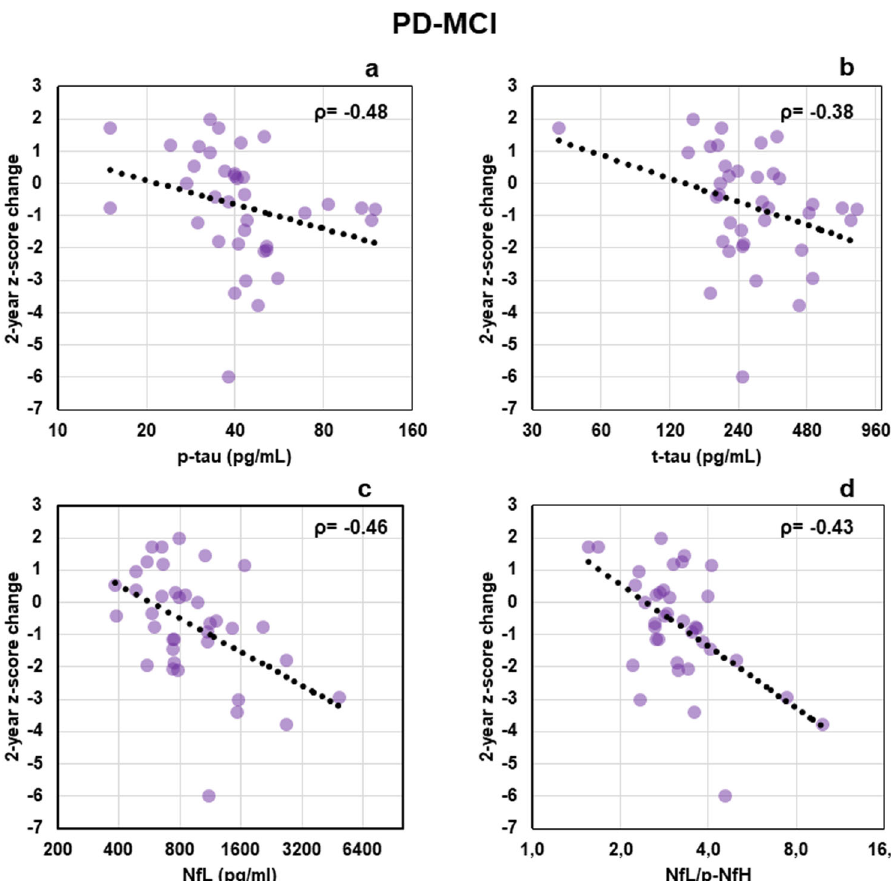
Fig. 2 Scatter plots of correlations between biomarkers and Z -score change of cognitive tests. a p-tau, b t-tau, c NfL, d NfL/p-NfH. The reported correlations produced, in the different groups, Spearman correlation coef fi cients signi fi cantly different from 0 after FDR correction and p -values < 0.05 after a nonparametric regression that considered age, sex, and disease duration as covariates. In order to allow a better visual interpretation of the Spearman correlation, biomarker values are shown on a log2-scale, a log fi t was also added for visual purposes. NfL